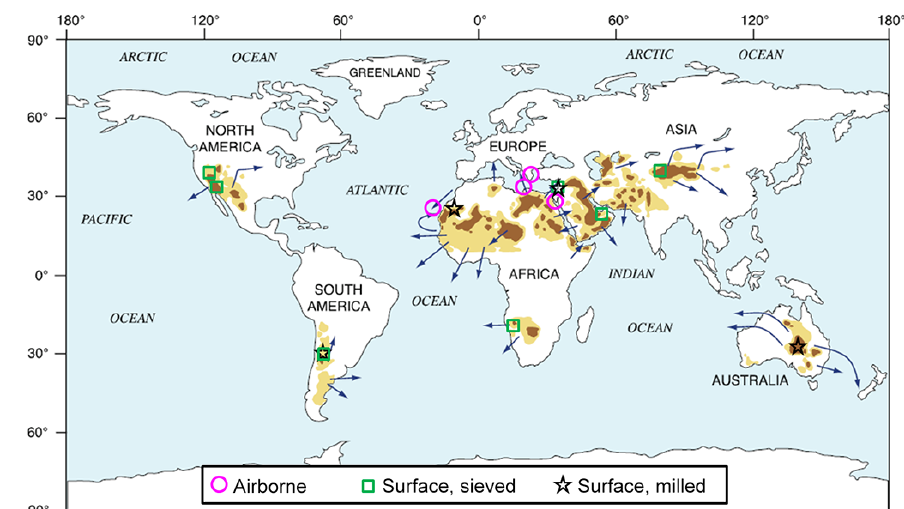
Figure 1. Collection sites of the dust samples. Green squares/black stars indicate sieved/milled samples which were collected directly from the surface; pink circles indicate samples that were collected either directly from the air or by deposition after transport from the Sahara. See text for details on the collection methods and treatment after collection. The map was adapted from Knippertz and Stuut (2014) and is based on data from Total Ozone Mapping Spectrometer (TOMS) satellite data of the absorbing aerosol index (AAI). Dark brown color indicates 21–31 days of AAI > 0.7, corresponding to significant amounts of dust or smoke. Yellow indicates 7–21 days of AAI > 0.7. Arrows show typical dust transport pathways in the atmosphere.